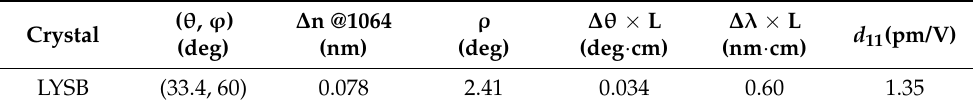
Table 5. NLO properties of the Czochralski-grown LYSB crystal for type-I SHG of 1064 nm fundamen- tal wavelength. (Adapted with permission from ref. [13], copyright 2019 American Chemical Society).